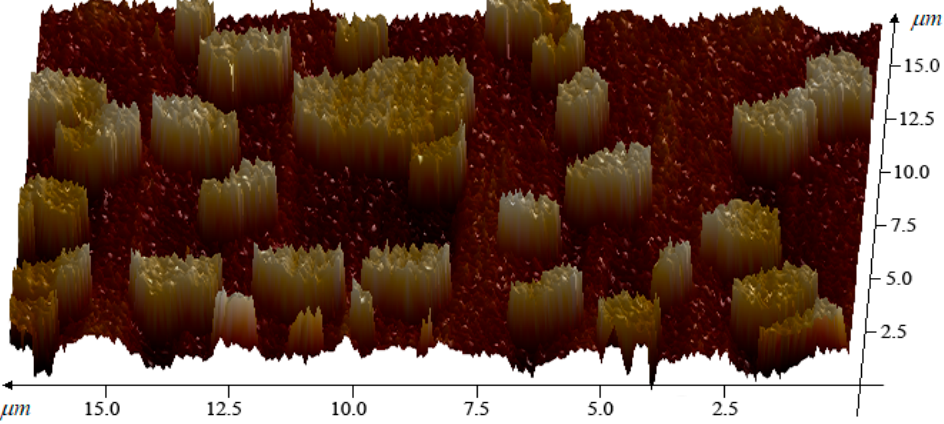
Figure 3. Expanded graphite and MEG 30,000 × magnification. MEG is dispersed in small flakes with single lateral size between 0.5–5 μ m and rela ‐ tively uniform thickness; this large size flake structure is conducive to assisting metal fill ‐ ers to form conductive pathways.